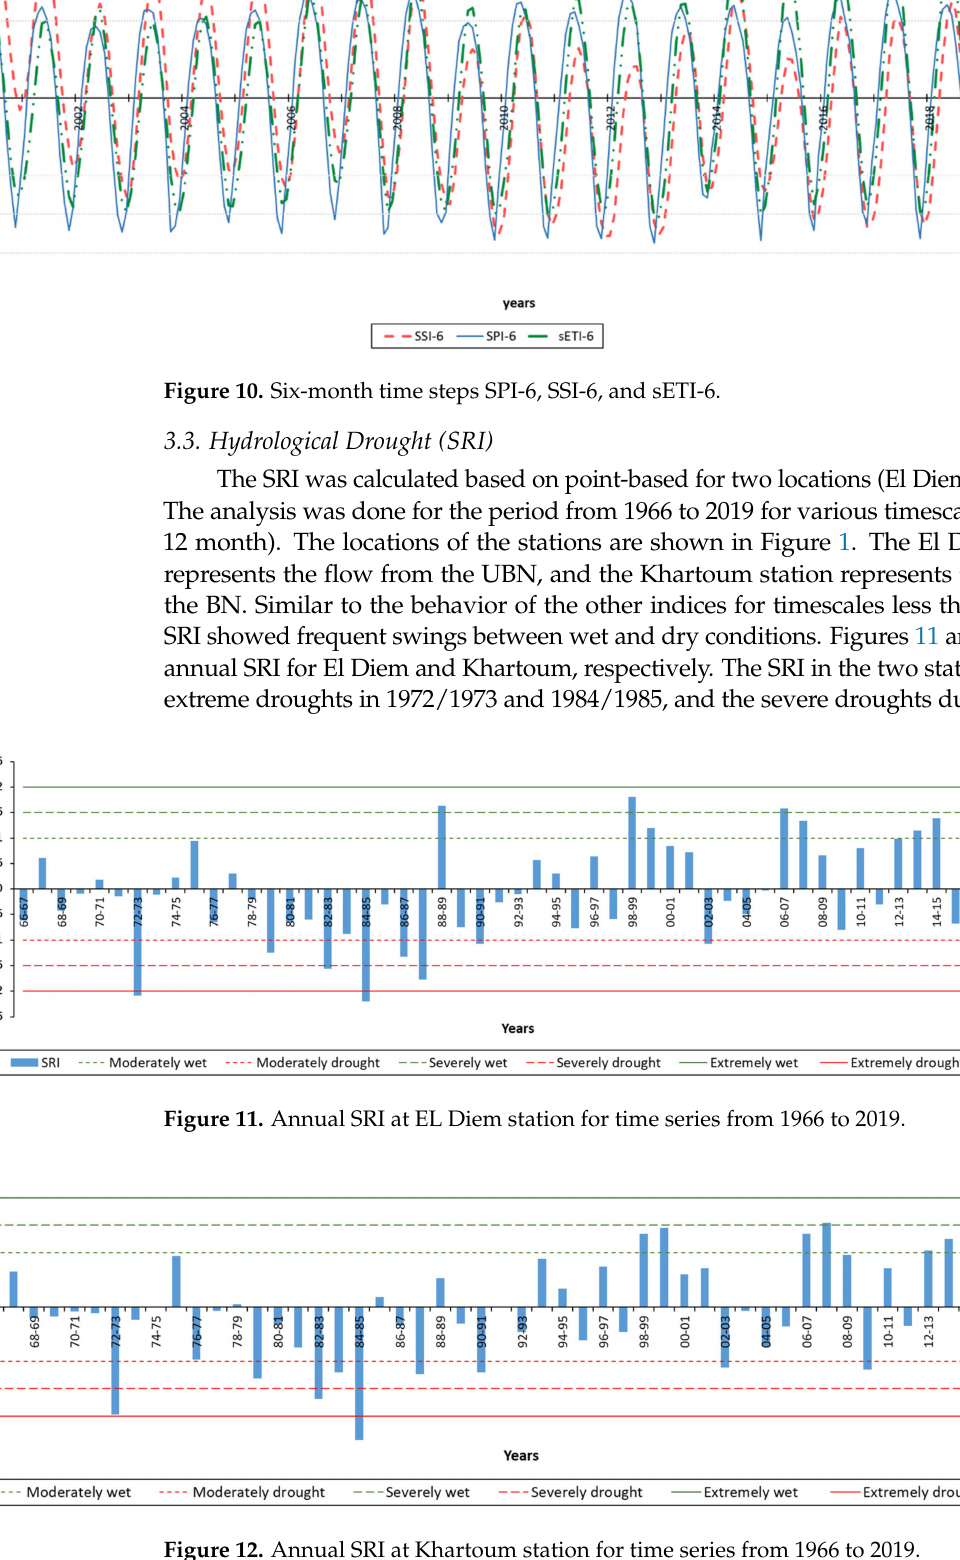
Figure 12. Annual SRI at Khartoum station for time series from 1966 to